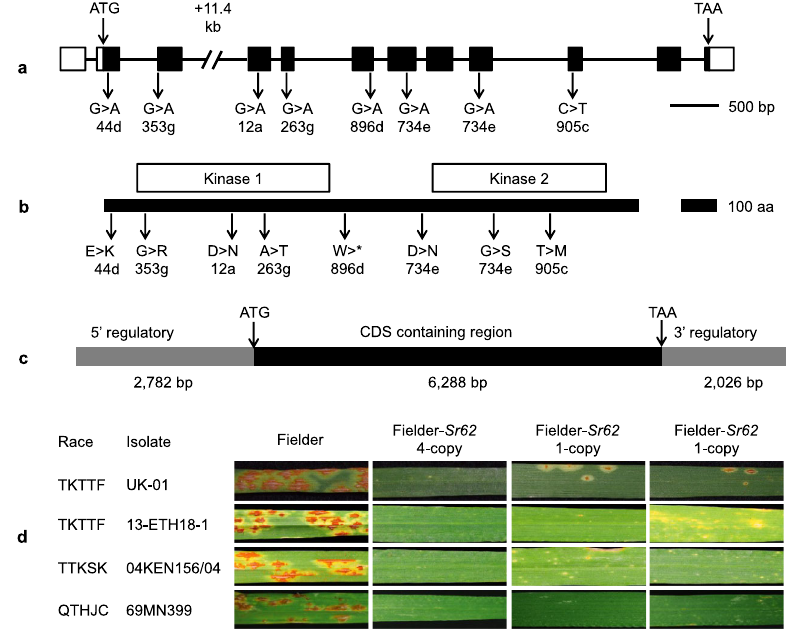
Fig. 3 Functional validation of Sr62 by EMS mutagenesis and transformation into wheat. a Structure of Sr62 , with predicted nucleotide change caused by EMS-derived loss-of-function mutations. Boxes represent exons and lines represent introns with white boxes representing untranslated regions and black boxes representing the predicted open reading frame. The 11.4-kb portion of the third intron excluded from the binary construct is indicated. b Schematic representation of the Sr62 protein, with the position of the two protein kinase domains and the predicted amino-acid changes caused by the EMS mutations indicated. c The Sr62 sequence used for transformation of wheat cultivar Fielder. CDS, coding DNA sequence. d Reactions of three homozygous independent transgenic lines to four Pgt isolates. The copy number of the hygromycin selectable marker in T 0 plants is indicated.